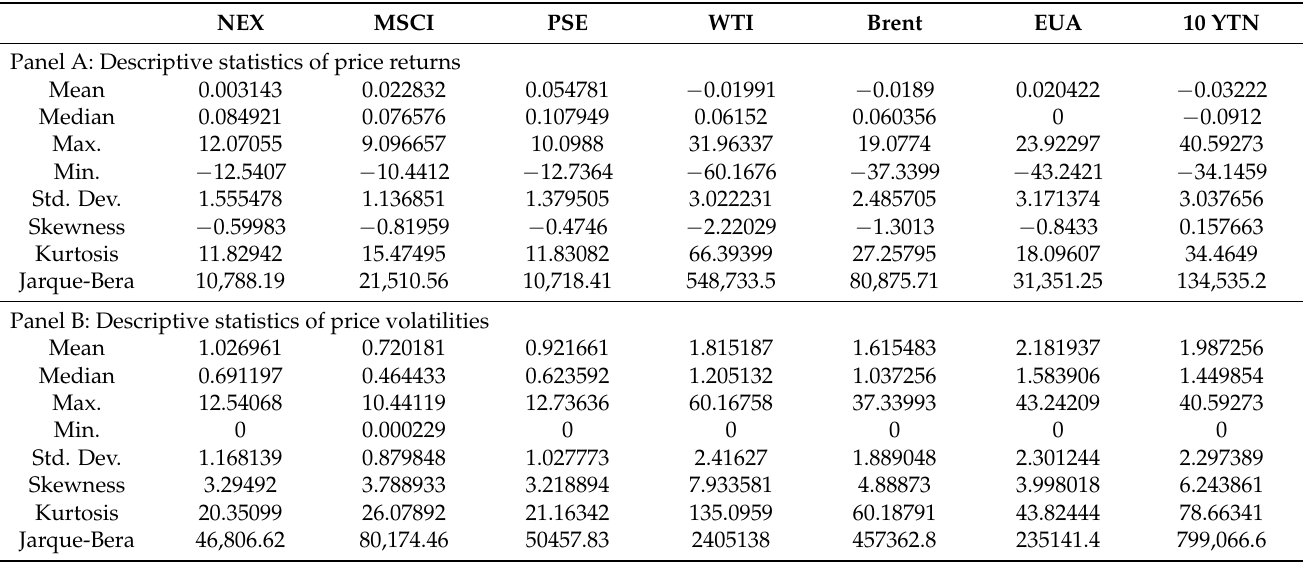
Table 1. Descriptive statistics of price returns and price volatilities.